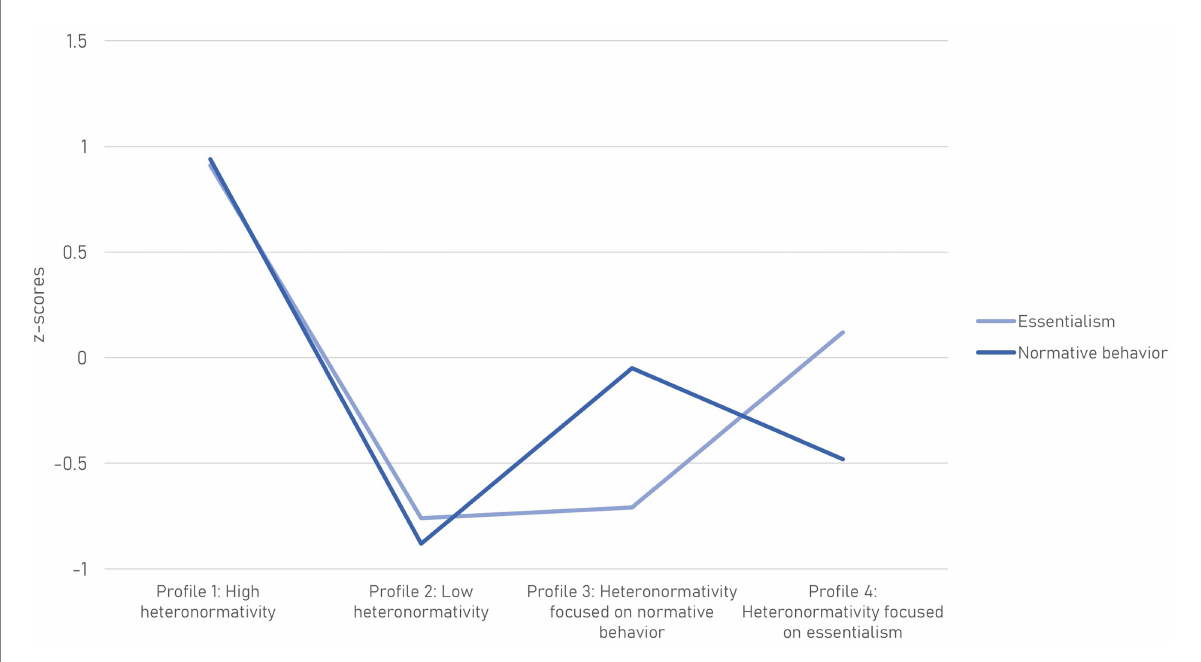
FIGURE 1 Heteronormativity profiles based on the scores of Essentialism and Normative behavior, the two dimensions of heteronormativity according to Habarth (2014). Differences in each dimension for each profile were p < 0.001.